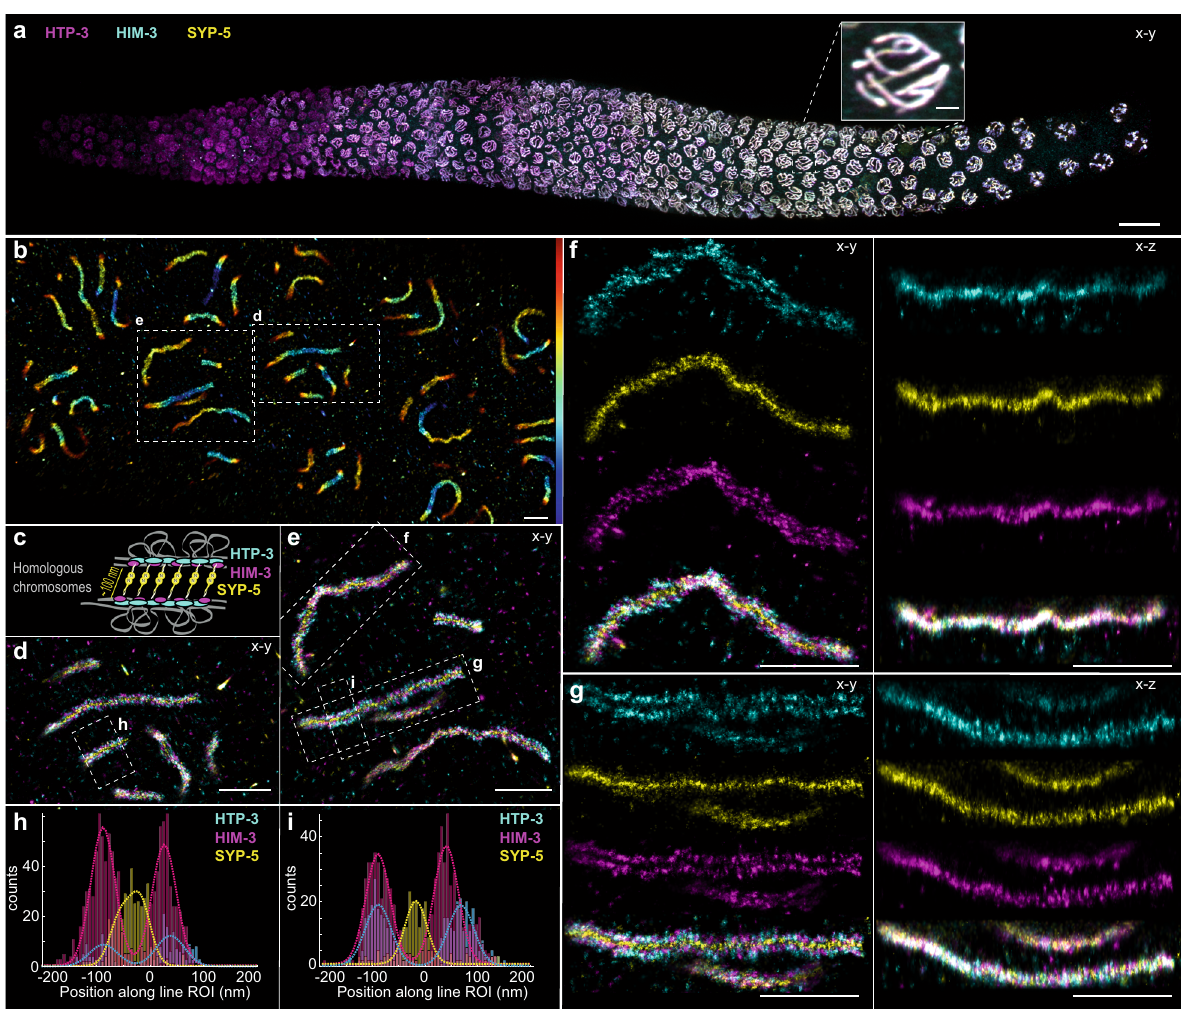
Fig. 5 Three-color 3D imaging of the synaptonemal complex in C. elegans . Ratiometric three color 3D astigmatism imaging of the synaptonemal complex components HTP-3, HIM-3 and the N-terminus of SYP-5. a Three channel maximum intensity projection image of a whole mount C. elegans gonad showing the synaptonemal complex components HTP-3, HIM-3, and SYP-5. To create the image of the whole gonad, individual tiles were stitched using the Grid/ Collection stitching Fiji plugin 45 . b Top view of the bottom-most section of meiotic nuclei, with rendered SMLM localizations of the synaptonemal complex components colored by their z coordinate (z range − 400 to 400 nm). c Cartoon showing relative positioning of the target proteins within the structure of the synaptonemal complex (based on previous research 31 – 33 ). d , e Zoomed-in image of the regions indicated in ( b ). f , g Top-view and side-view images of the synaptonemal complex stretches indicated in ( e ). h , i Histograms of localization counts along the 300 nm wide ROIs, as indicated in ( d , e ).